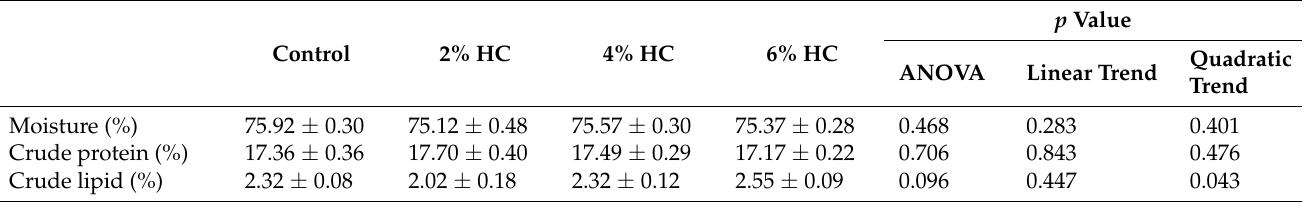
Table 7. Effects of hydrolyzed collagen replacing fish meal on muscle nutrition components of triploid crucian carp (% wet basis).